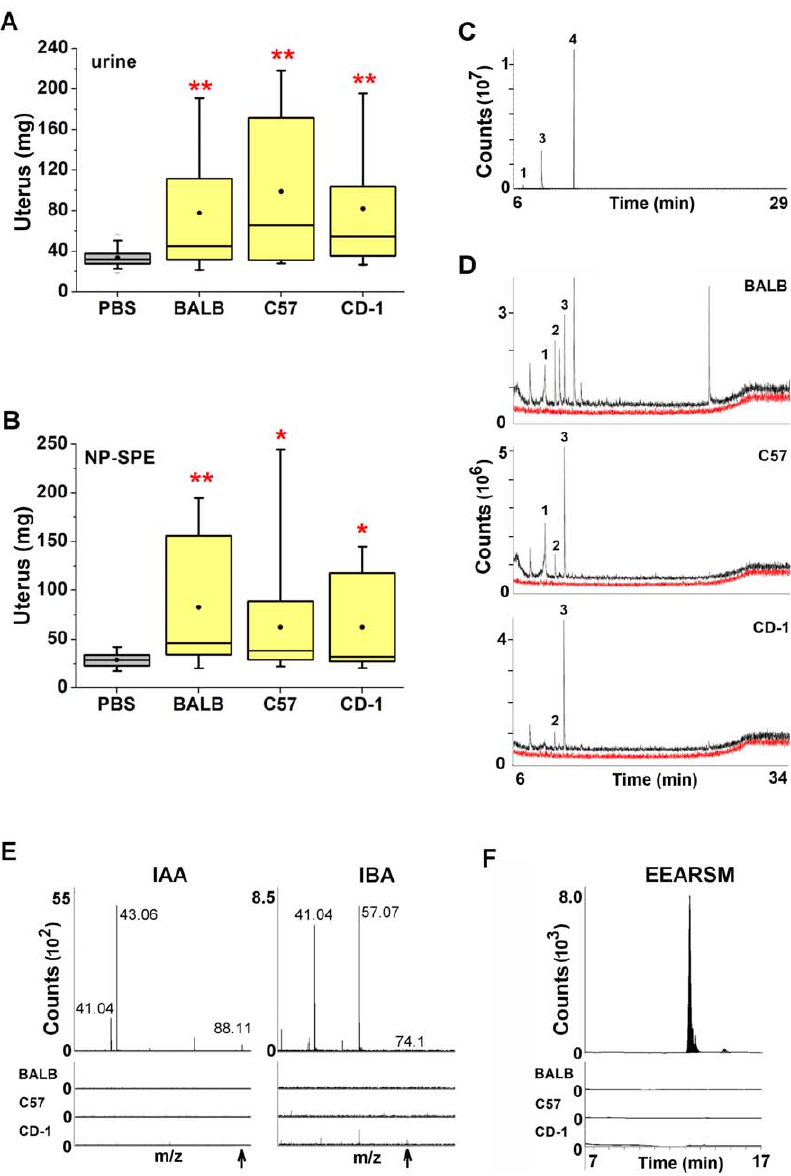
Figure 4. Known pheromones are not present in the bioactive NP-SPE fraction from three different strains. ( A ) Male urine of BALB/cJ, C57BL/6J, and CD-1 each diluted 1:3 in PBS promotes uterine weight increase in female mice (Dunnett’s). (End body masses are not significantly different, p=0.839). Averages of body mass (g): PBS, 17.29; BALB/cJ, 17.47; C57, 17.40; CD-1, 17.26. n=27 per group. ( B ) Females exposed to the NP- SPE amino-column elutions from three different mouse strains display uterine weight gain (Dunnett’s). (End body masses are not significantly different p=0.662.) Averages of body mass (g): PBS, 17.41; BALB/cJ, 17.40, C57, 17.39; CD-1, 17.11.n=14–15 per group. ( C ) GCMS chromotograph of pheromone standards HMH (1), SBT (3), and b -farnesene (4) as indicated. Fragmentation patterns of standards were used for analysis. ( D ) GCMS total ion chromatographs for known pheromones from total urine (black trace) and bioactive NP-SPE fractions (red trace) from BALB/c, C57BL/6J, and CD-1 male donors. Detection of HMH (1), DHB (2), and SBT (3) are indicated. No extractable compounds, including these known pheromones, were detectable in NP-SPE samples. The NP-SPE red trace is offset below the urine trace to visualize the lack of detectable peaks, the y-axis is otherwise identical. ( E ) LCMS/MS analysis of bioactive NP-SPE samples from BALB/c, C57BL/6J, and CD-1 male donors does not detect the presence of IAA and IBA using fragmentation patterns obtained from standards (top) as indicated. Arrow indicates the exact mass of the parent ion. ( F ) Analysis of EEARSM peptide using the mass of the transition state during dissociation of the standard (top). EEARSM was not detectable in any of the NP-SPE samples from any strain. In panels E-F the y-axis are identical between standards and NP-SPE samples. *p , 0.05, **p , 0.01.